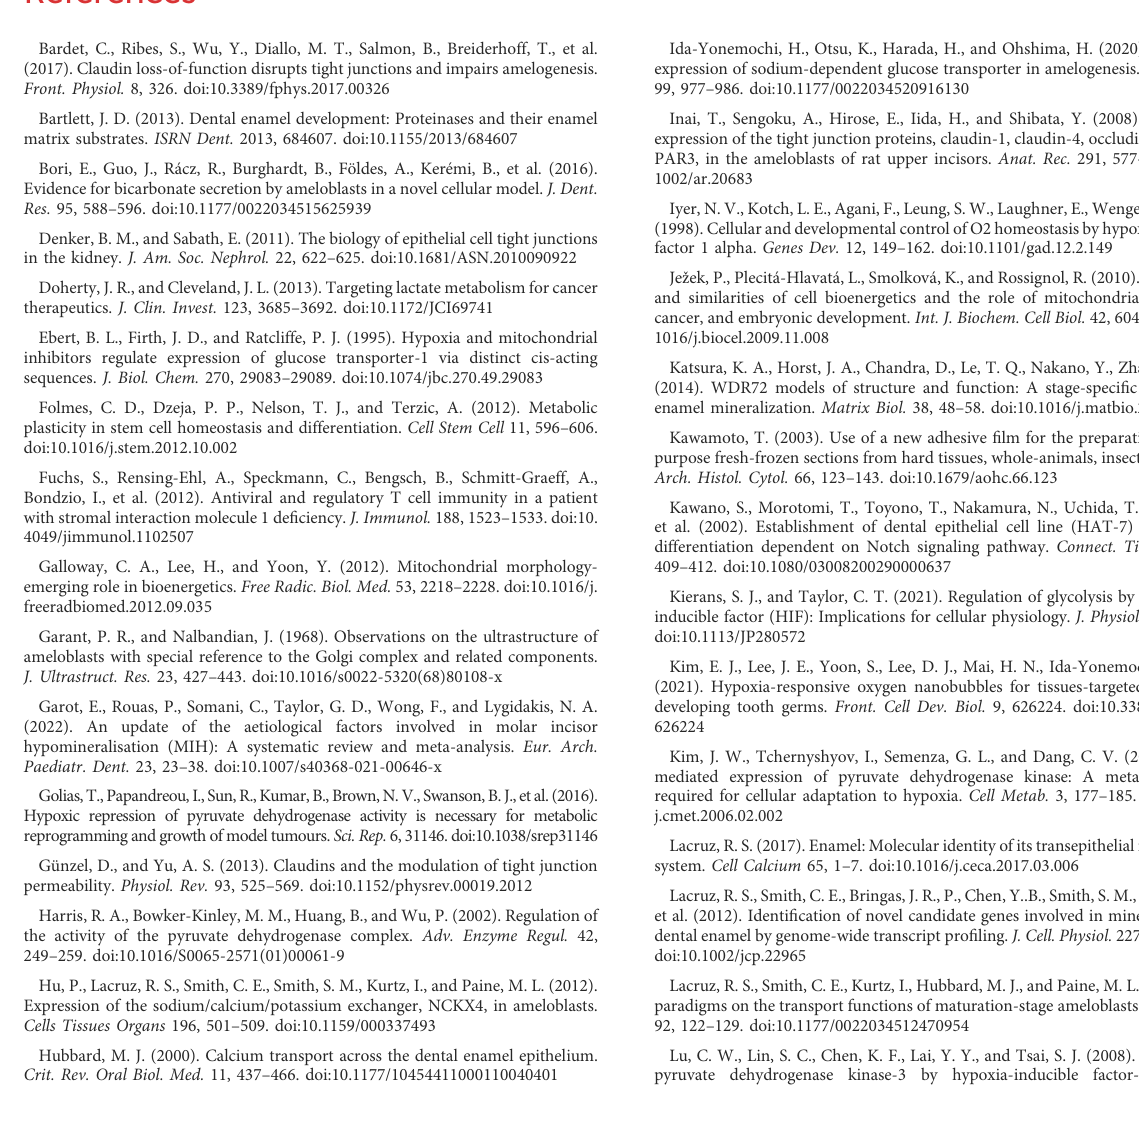
DAPI staining of HAT7 cells cultured on plastic plates coated with collagen type I for alizarin red staining. (A) DAPI staining of HAT7 cells cultured under normoxia (left) and hypoxia (right) for 7 days. (B) DAPI staining of HAT7 cells cultured with DMSO (left: control) and UK-5099 (right) for 5 days. Scale bars, 200 μ